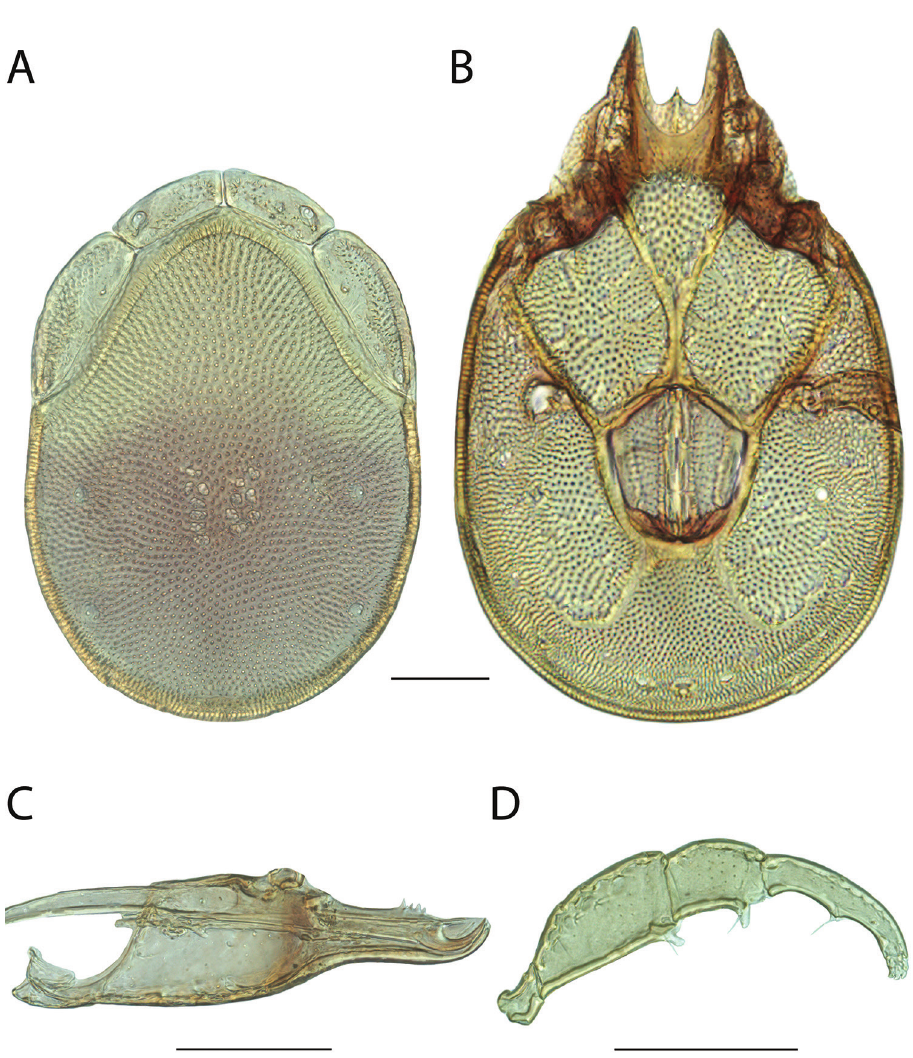
Figure 54. Torrenticola dentirostra sp. n. female: A dorsal plates B venter (legs removed) C subcapitulum D pedipalp (setae not accurately depicted). Scale = 100